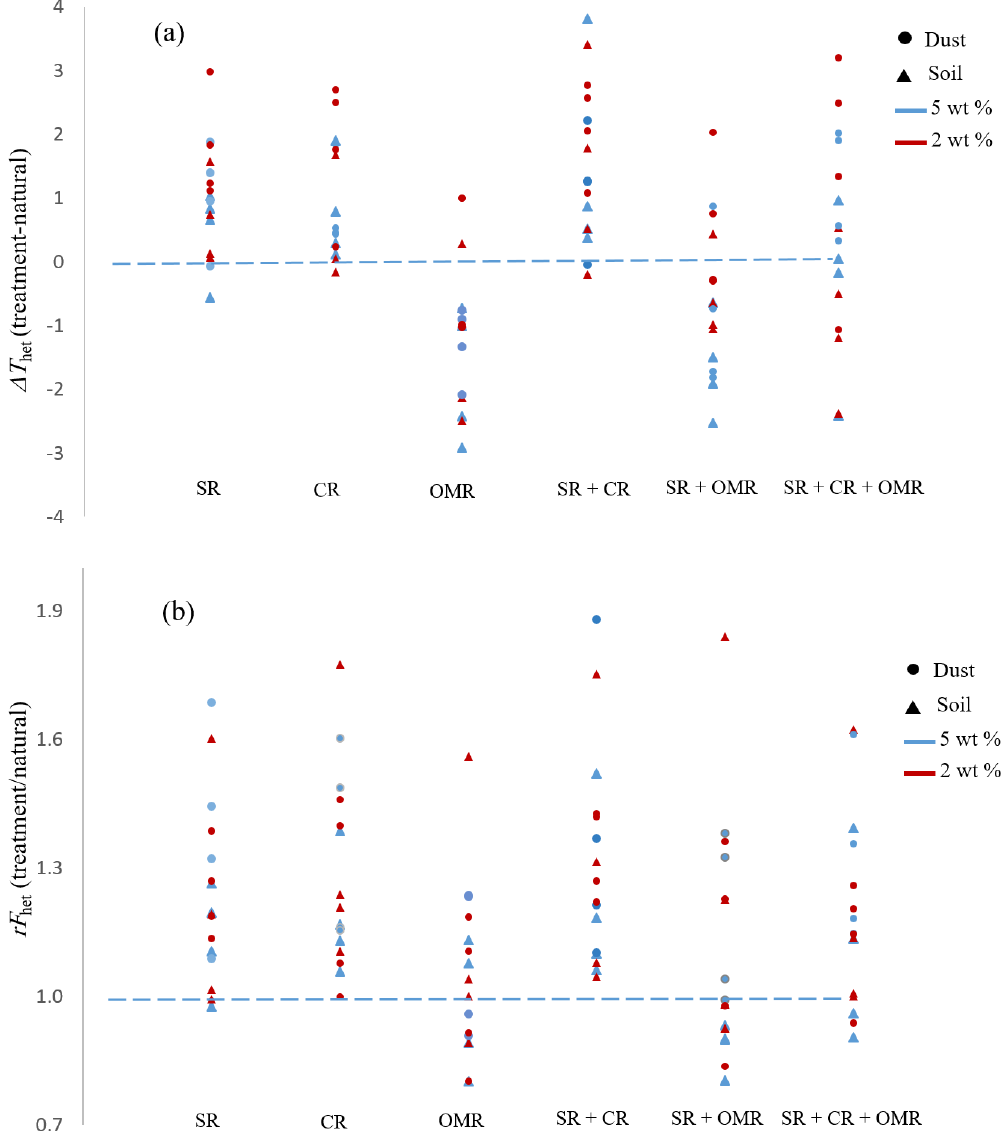
Figure 6. (a) Effect of treatments on T het . Points above 0 (shown as dashed lines) represent the increase in T het after the treatment. (b) Rel- ative change in F het after the treatments. Points above 1 show an increase in F het of the treated samples compared to the natural